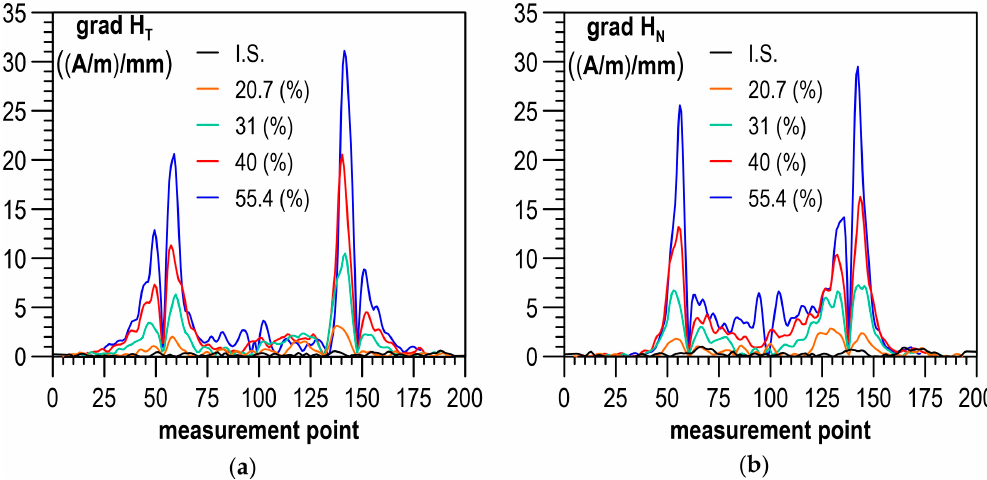
Figure 7. Distribution of the gradient of the RMF components for different plastic deformation states: ( a ) gradient of tangential component grad H T ; ( b ) gradient of normal component grad H N .